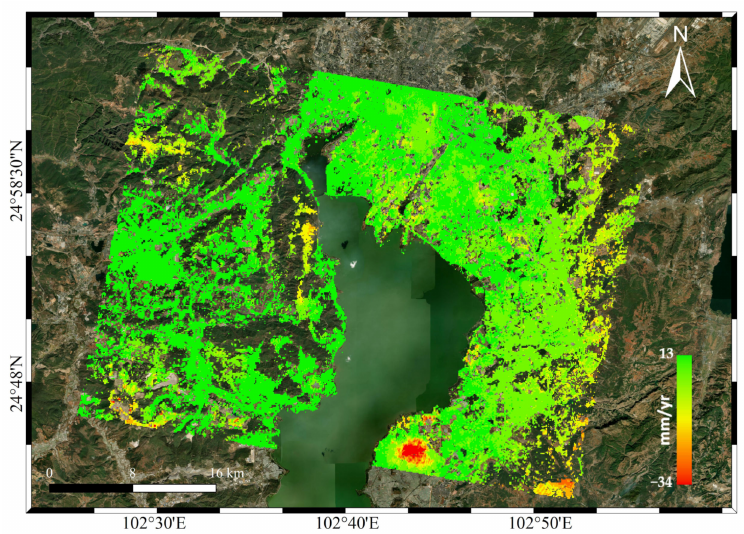
Figure 9. Subsidence rate map of the study area obtained after time series